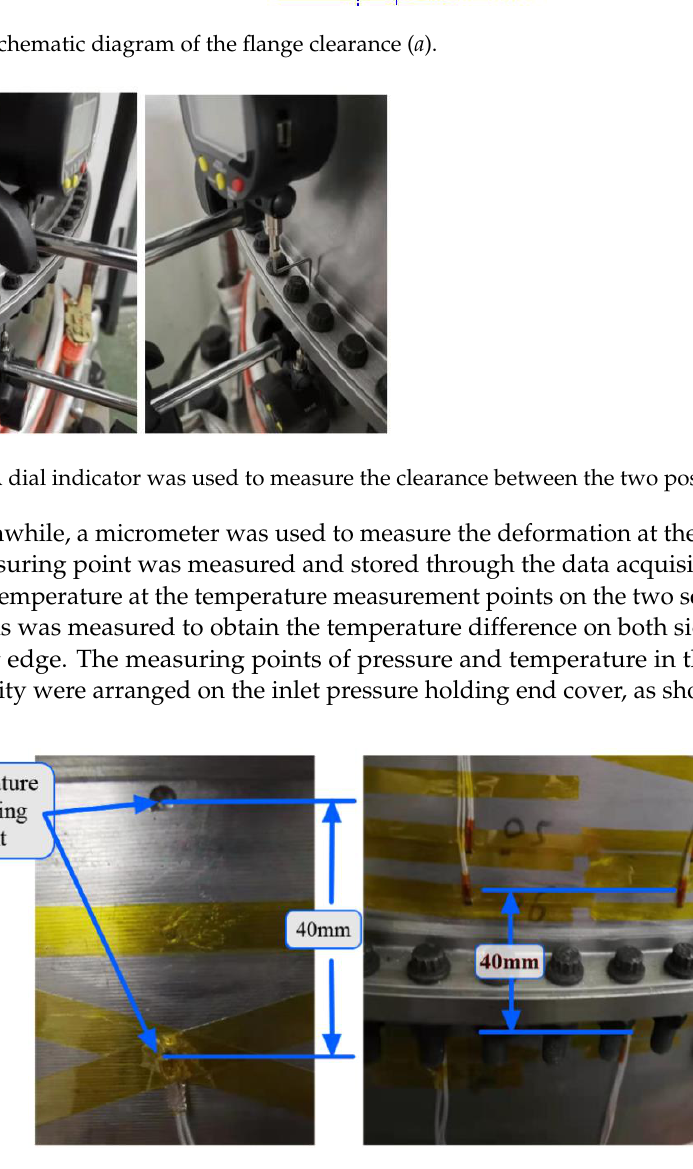
Figure 10. Arrangement of temperature measuring points and platinum resistance in the experi- mental